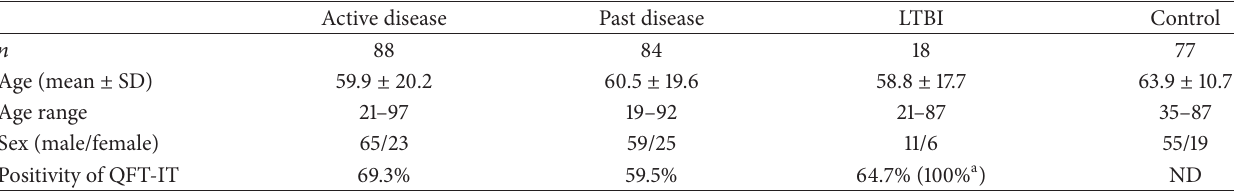
Table 1: Characteristics of patients in this